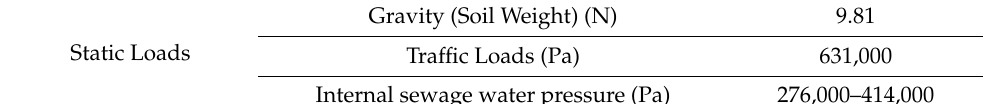
Table 4. Static loading proposed for the validation of numerical results.